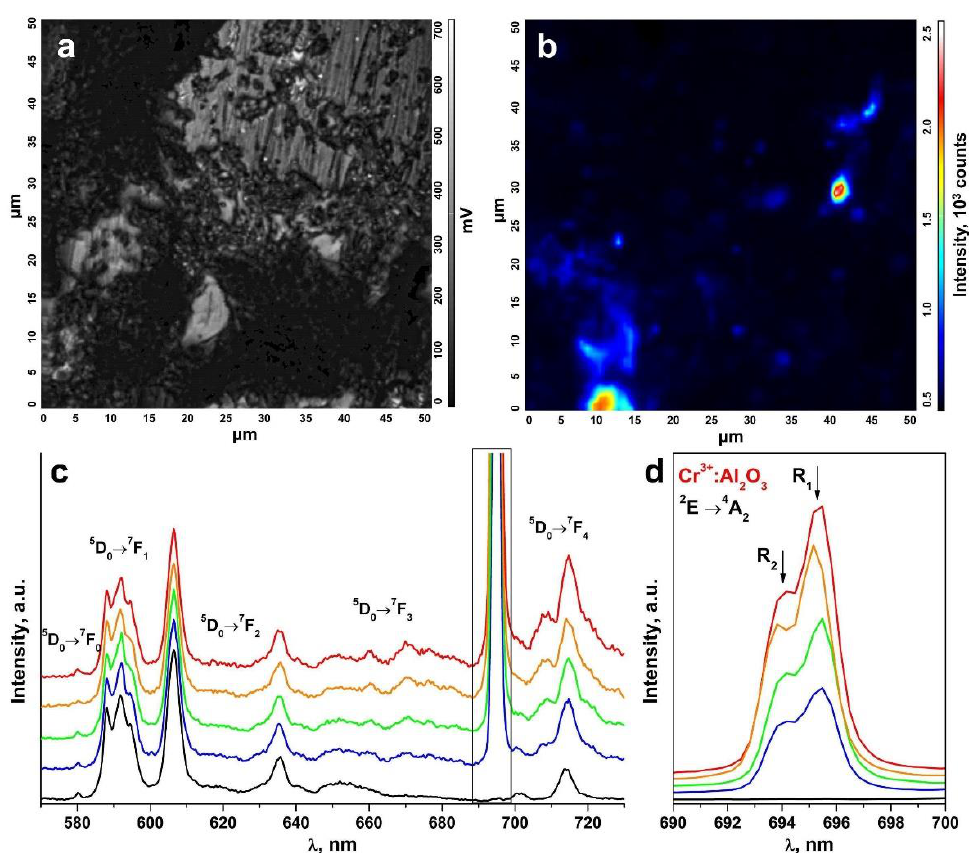
Figure 8. ( a ) Surface image of a ceramic specimen synthesized using uniaxial compaction; ( b ) R 1 and R 2 luminescence band intensity distribution map for the Cr 3+ ions in Al 2 O 3 on the surface area shown in Figure 8a; ( c ) luminescence spectra of the ceramic specimen excited with a λ = 473 nm laser (T = 300 K) corresponding to the intensity scale in Figure 8b; ( d ) R 1 and R 2 luminescence bands of the Cr 3+ ions in Al 2 O 3 for the 2 E → 4 A 2 transition. The excitation spectra of the (ZrO 2 ) 0.909 (Y 2 O 3 ) 0.09 (Eu 2 O 3 ) 0.001 ceramics (Figure 10)